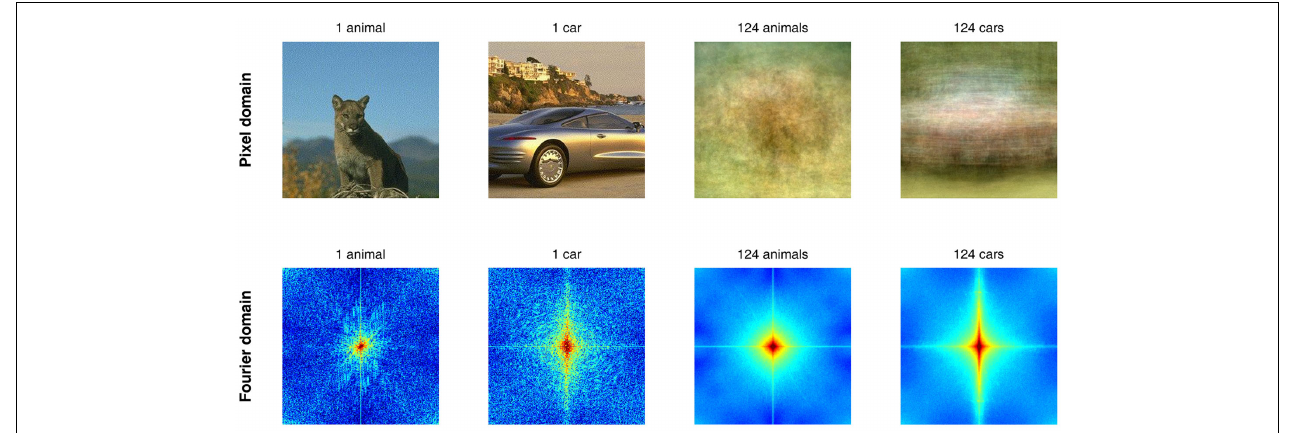
(a “hazy” view of) an animal, whereas the average of 124 cars is much more similar to a car picture.The same can be said of averages in the Fourier domain (bottom). A simple “detector” or “classifier” using the two patterns on the right as templates would easily distinguish between the two examples on the left, without any need for feature, object, or category